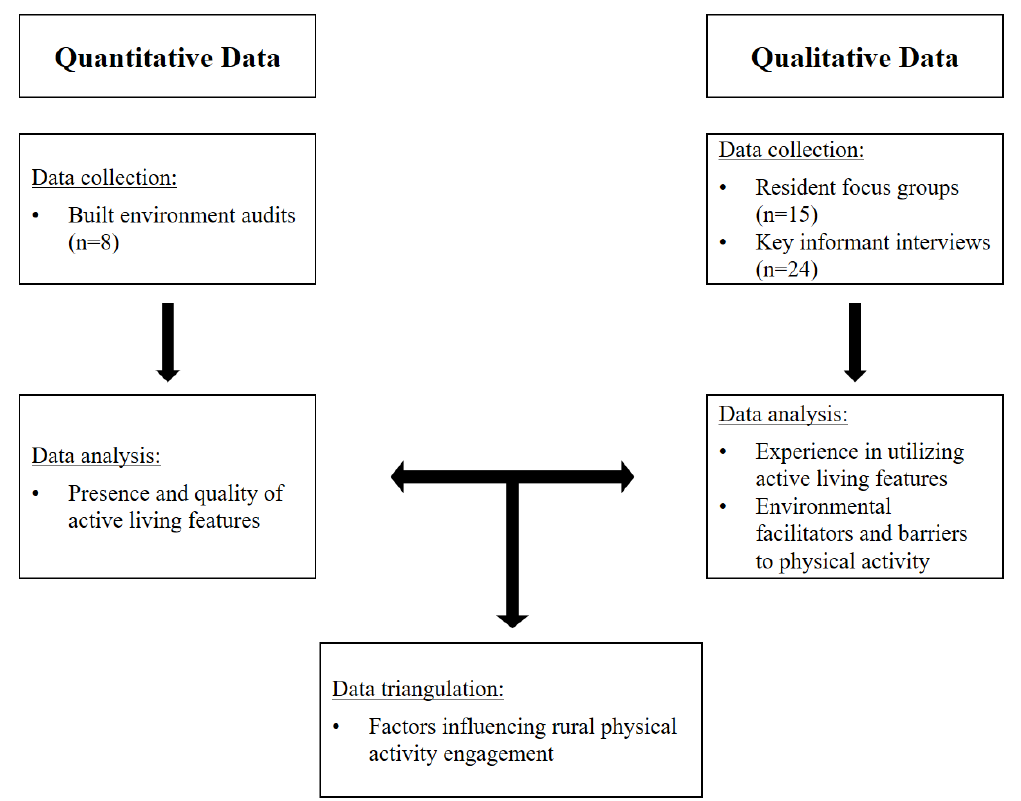
Figure 1. Data collection, analysis, and interpretation process.